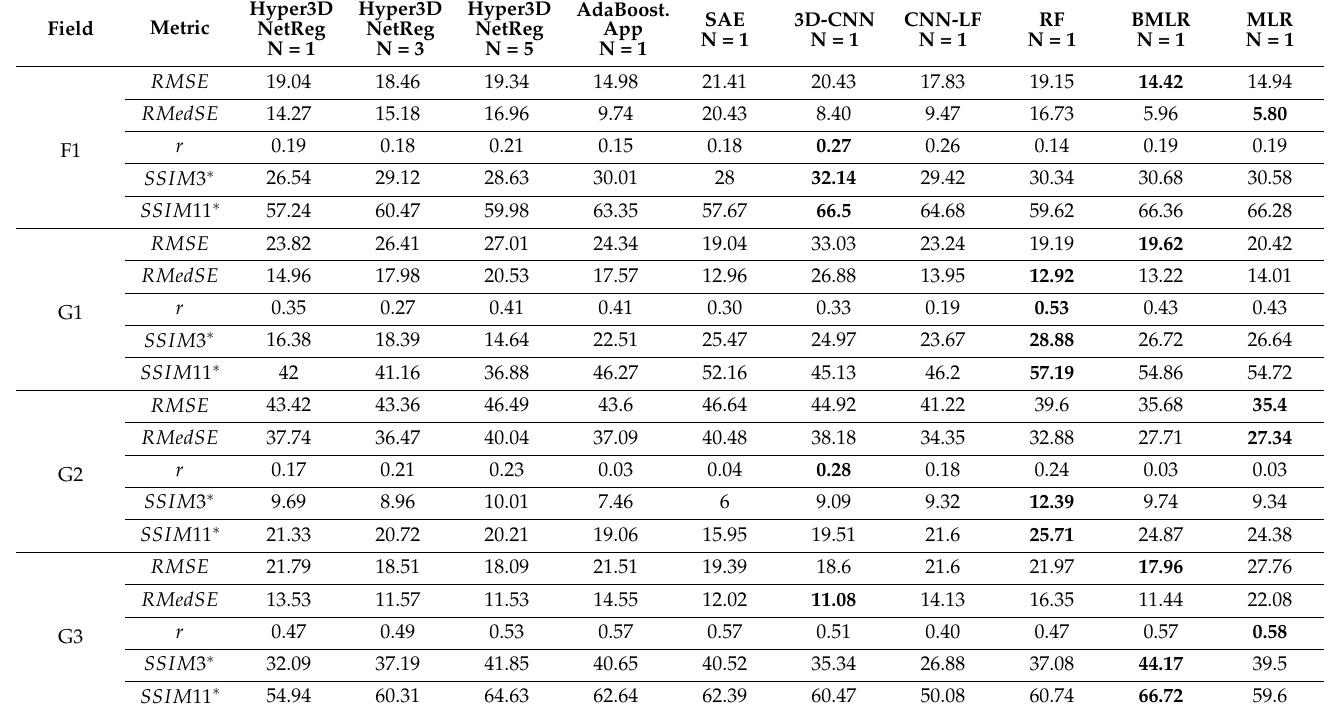
Table 5. Yield prediction comparison (split B). Best-performing metrics are highlighted in bold. SSIM 3 ∗ and SSIM 11 ∗ are SSIM values multiplied by